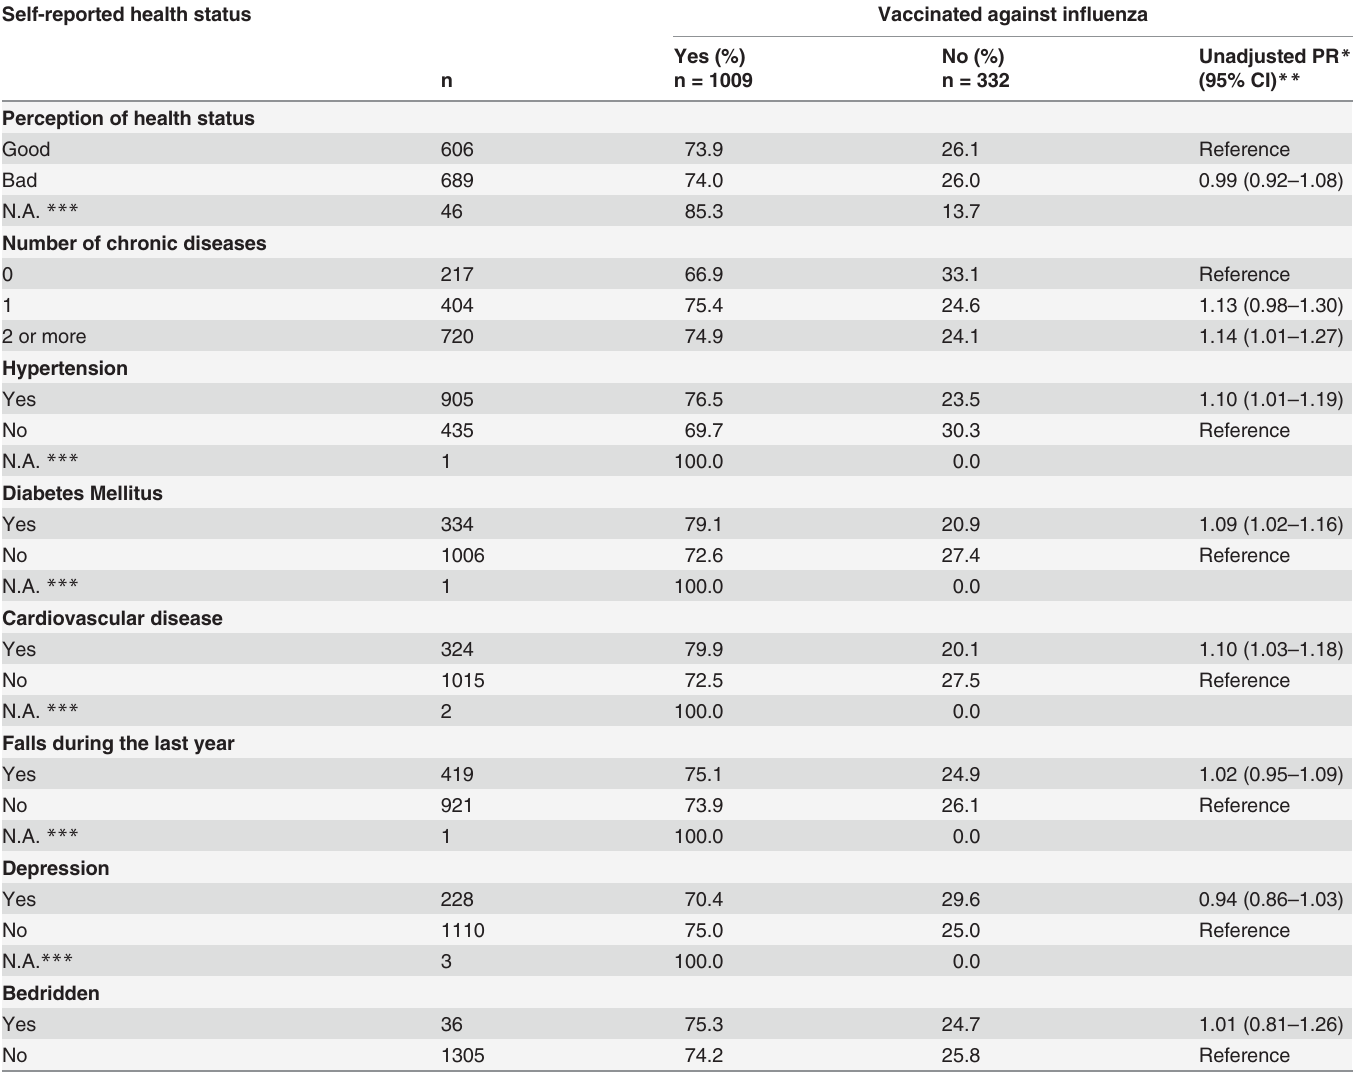
Table 3. Influenza vaccination among the elderly (n = 1,341) by self-reported health status. S ã o Paulo, Brazil,